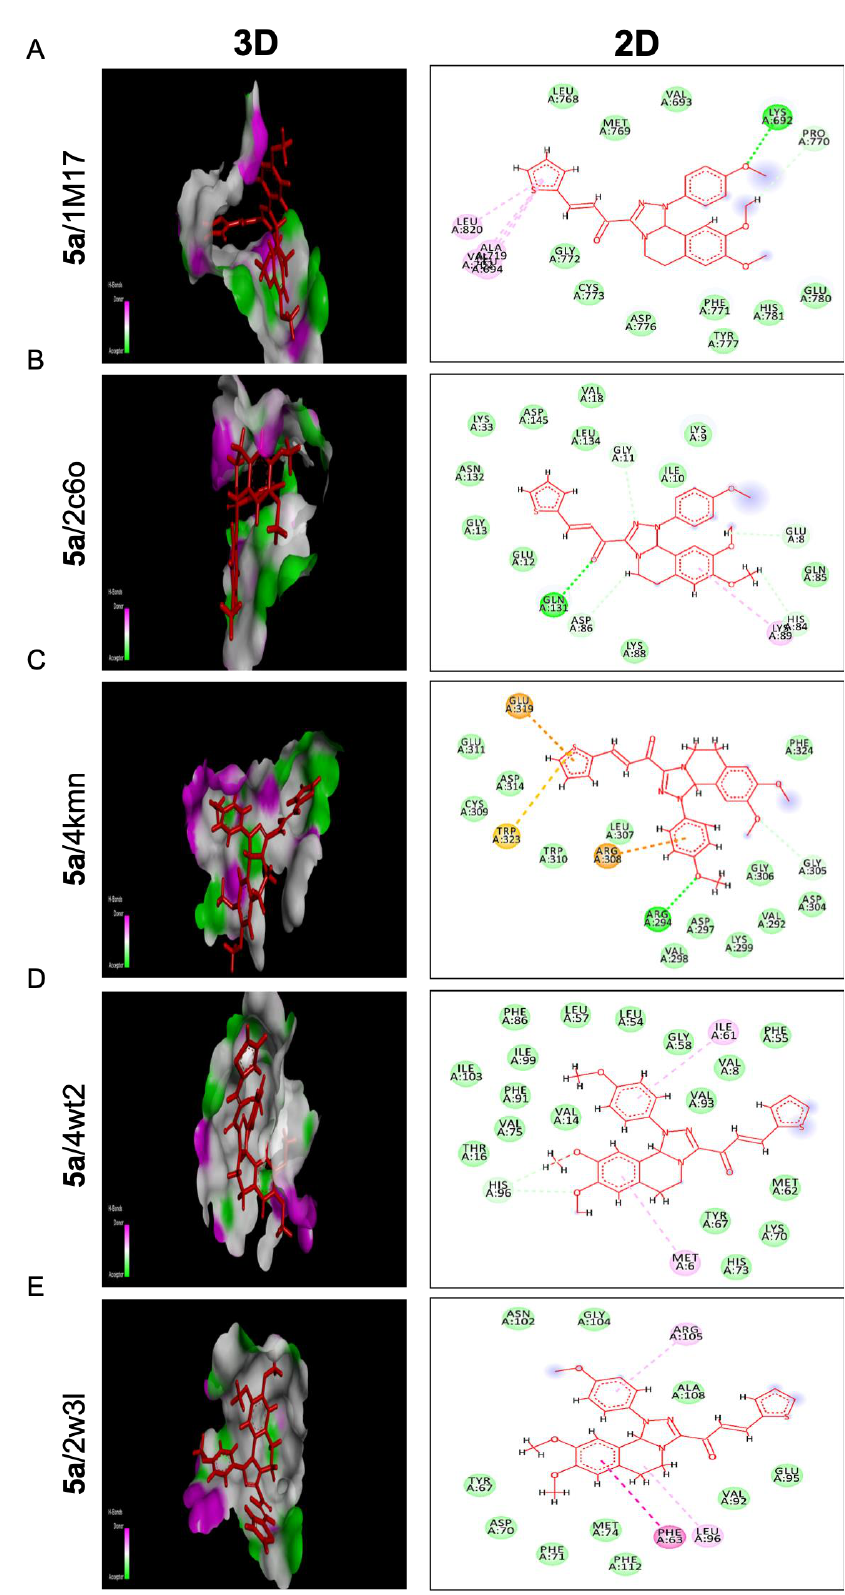
Figure 7. Molecular docking analysis of chalcone compound 5a. Representation of 3D and 2D modeling into the active site of ( A ) epidermal growth factor receptor tyrosine kinase domain (1m17), ( B ) cyclin-dependent kinase 2 domain (2c6o), ( C ) cellular inhibitor of apoptosis protein 1 domain (4kmn), ( D ) mouse double minute 2 domain (4wt2), and ( E ) B-cell lymphoma 2 domain